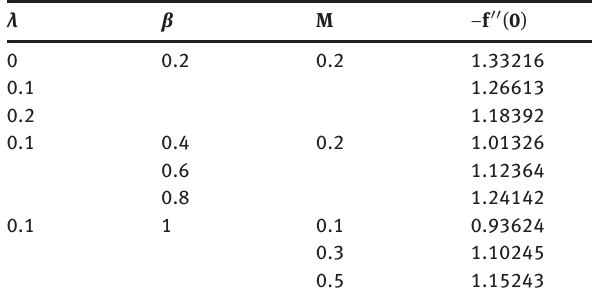
Fig. 6: Variation of velocity f (cid:3) ( η ) with η for several values of relax- ation ratio parameter λ .